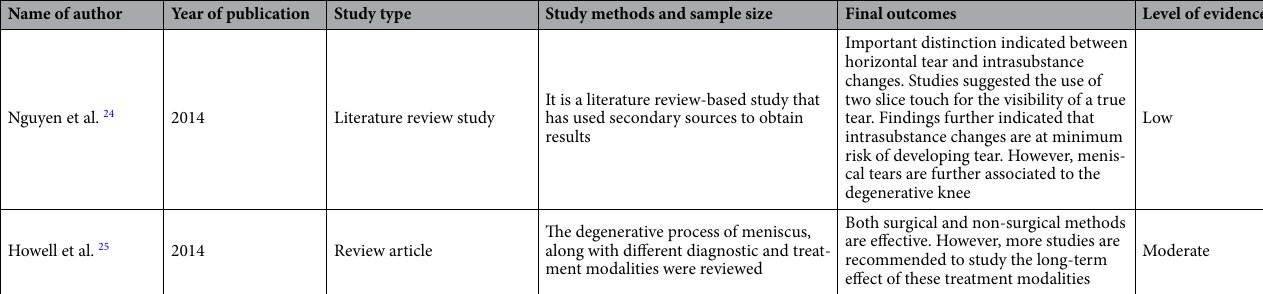
Table 1. Characteristics of included studies.